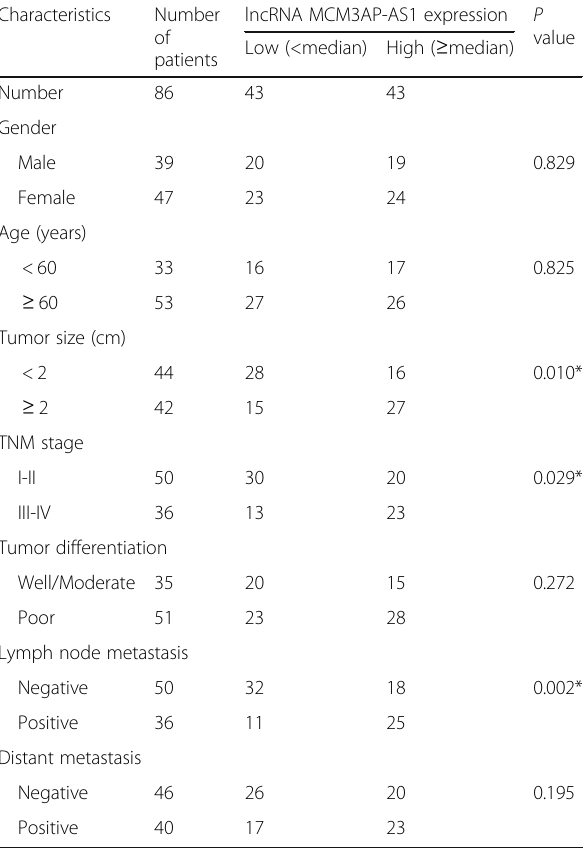
Table 1 The characteristics of the patients with PC